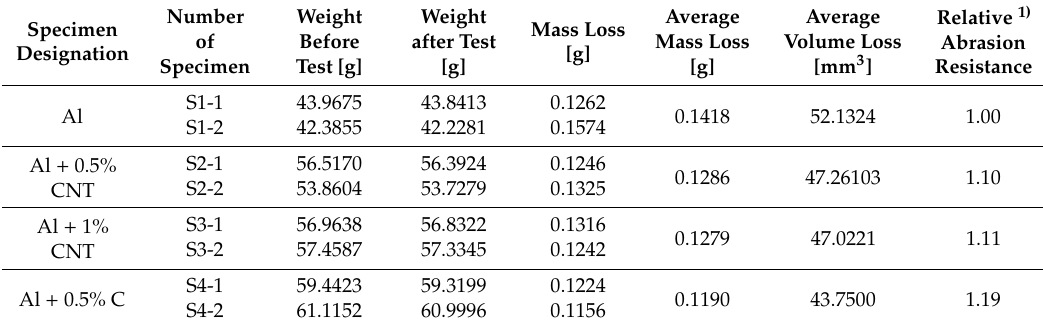
Table 6. Summary of results obtained during the abrasive wear test ASTM G65 [42].